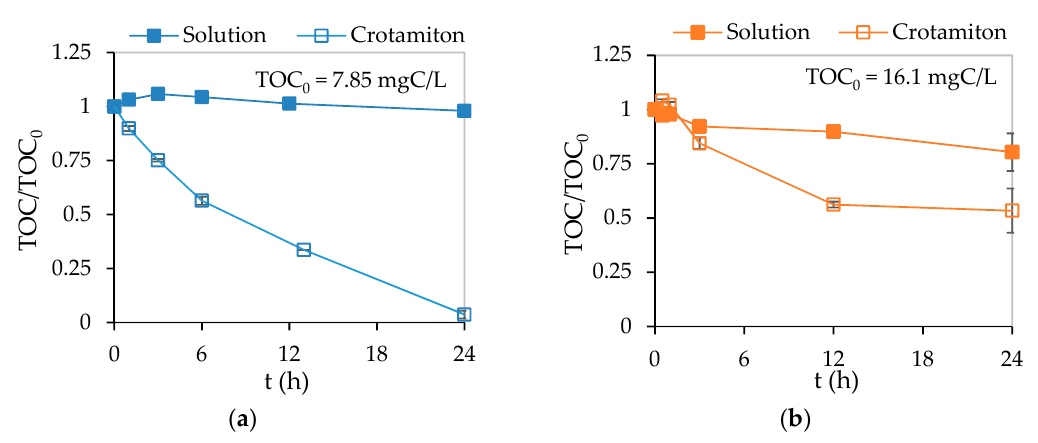
Figure 4. Removal of TOC in the solutions and the TOC derived from the residual crotamiton during the treatment by the F9/P25 composite sheet with ultraviolet irradiation in ultrapure water ( a ) and RO concentrate ( b ). Results are means ± standard deviations ( n = 2).